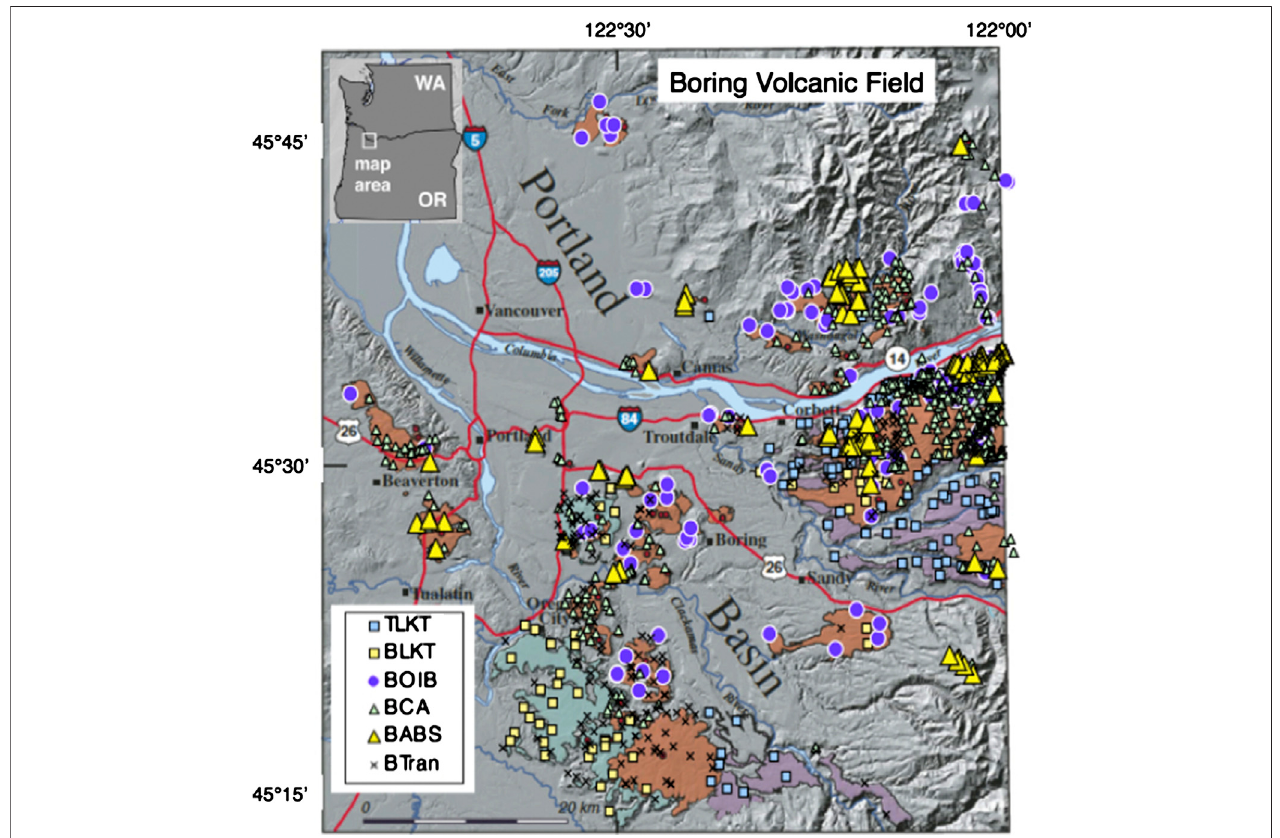
FIGURE8| LocationsofanalyzedsampleswithinthePortlandBasinforearcregionoftheCascadearc(Leemanetal.,2019).BasemapisfromEvartsetal.(2009). Symbols denote chemical af fi nity for individual samples collected at those locations. Map colors show distribution of locally erupted volcanic rocks (in orange except for BLKT tholeiites (blue-green), and TLKT tholeiites (purple) from High Cascades vents east of the map area.